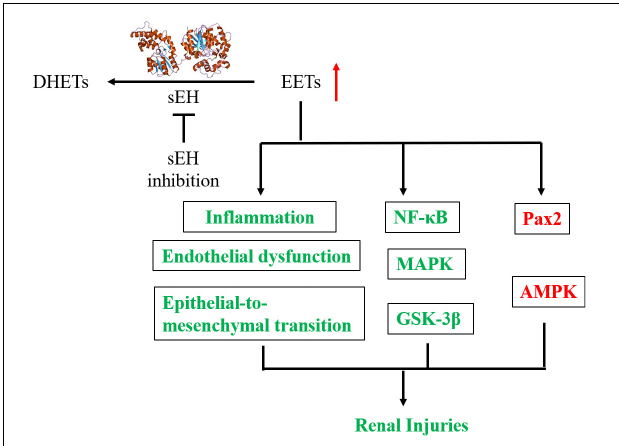
FIGURE 4 | A putative mechanic summary of reno-protection of sEH inhibition. The items highlighted with red mean increased while those with green mean decreased caused by sEH inhibition with a chemical inhibitor or generic